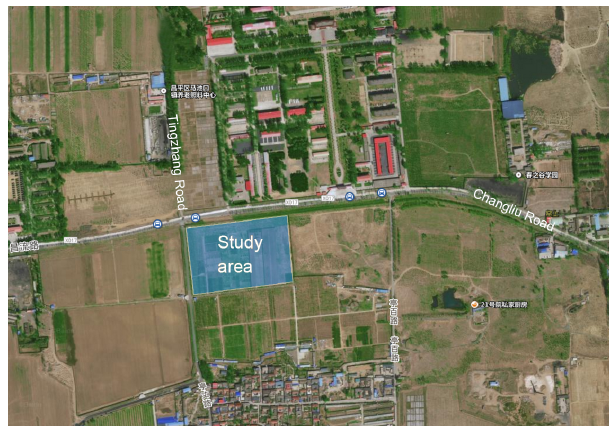
Figure 1. Map of the study